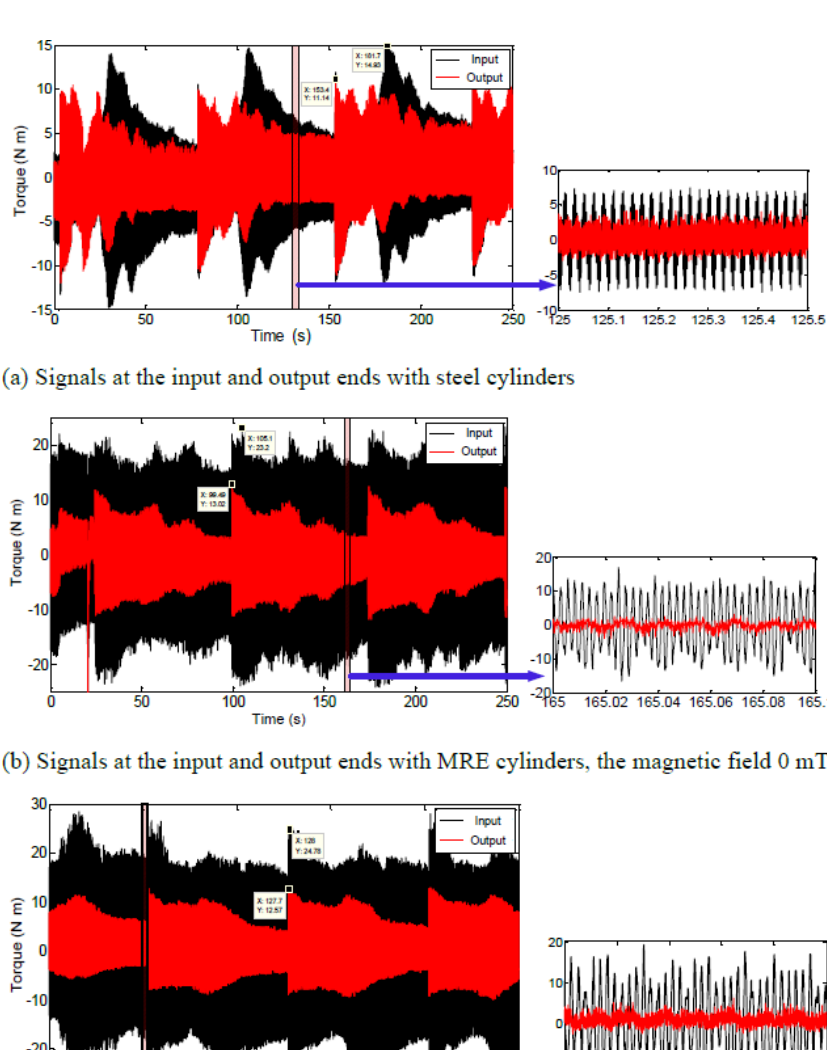
30.81 Hz when the external magnetic field is null, while the natural frequency of the structure with MRE cylinders is 35.32 Hz, which is consistent with the simulation result in Fig. 9. On the other hand, when the external magnetic field is 500 mT, the natural frequency of the structure with MRE cylinders is 40.09